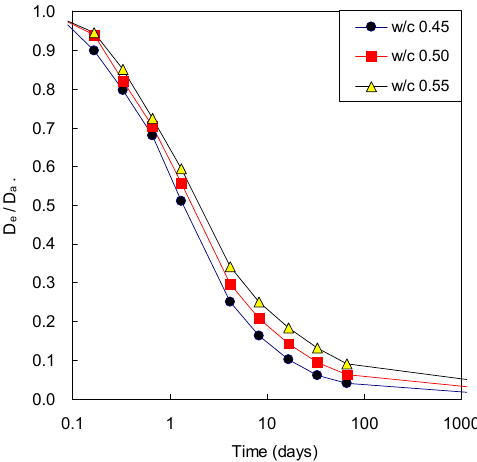
Figure 6. Comparison of effective CO 2 diffusivity of concrete (D e ) and apparent CO 2 diffusivity (D a ) before carbonation.